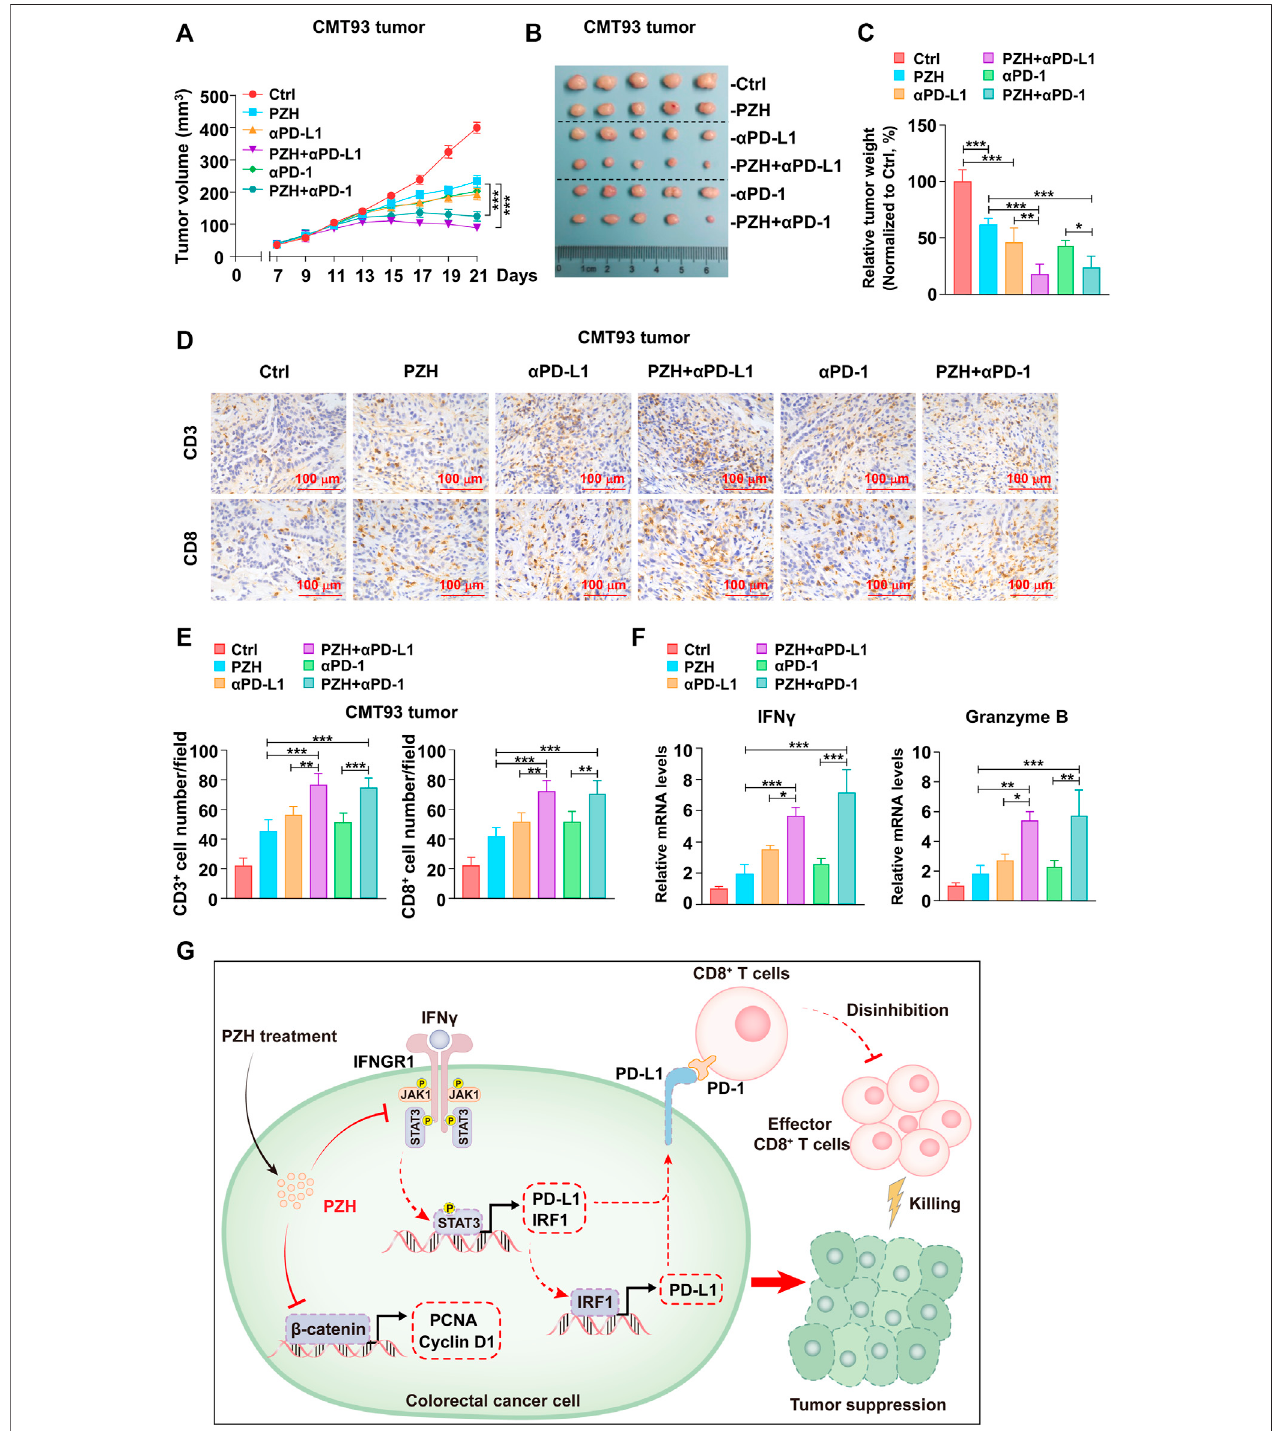
FIGURE 6 | PZHsynergisticallypromotedtheantitumoref fi cacyofanti-PD-1/PD-L1immunotherapy. (A – B) Thetumorgrowth (A) andsize (B) ofCMT93bearingmicewere attenuatedinthecombinationgroupscomparedwiththemonotherapygroupsatday21oftreatment( n =5pergroup):IgGcontrol,PZH(0.234 g/kg),PD-L1antibody(100 μ g),PZH + PD-L1 antibody combination group (PZH 0.234 g/kgand PD-L1antibody 100 μ g), PD-1antibody (100 μ g) and PZH+ PD-1 antibody combination group (PZH 0.234 g/kgand PD-1antibody100 μ g). (C) Thetreatmentef fi ciencyofcombinationgroupwashigherthanthatofmonotherapywitheitheragent( n =5pergroup).Thetreatmentef fi ciencywas quanti fi ed by tumor weight and normalized to the Ctrl group. (D – E) The number of tumor-in fi ltrating CD3 + and CD8 + cells was elevated in the combination groups with indicated treatments( n =5pergroup)asdescribedin (A – B) .CD3andCD8stainingwereperformedbyimmunohistochemicalanalysis,andthenumberofpositivecellswasanalyzedbyImage ProPlus6.0software. (F) ThemRNAlevelsofIFN γ andGranzymeBwereup-regulatedinthecombinationgroupswithindicatedtreatments( n =3pergroup)asdescribedin (A – B) . The results are representative of one of three experiments. Data are presented as means ± SD, * p < 0.05, ** p < 0.01, *** p < 0.001 based on one-way ANOVA.